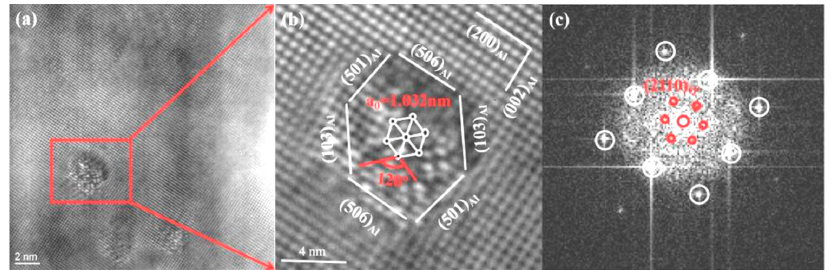
Figure 8. Q ′ phase in A2 alloy in the <010>Al axis after aging treatment: ( a ) TEM image, ( b ) HRTEM image, ( c ) corresponding FFT.